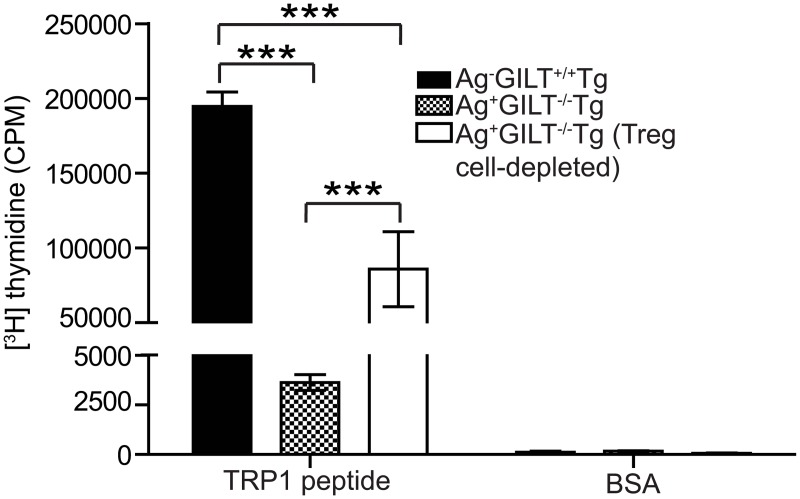
Treg cell depletion partially restores the ability of melanoma-specific T cells from TRP1-expressing mice to proliferate in response to antigen.Total CD4+ and CD4+CD25-T cells were FACS-sorted from Ag+GILT-/-Tg mice and cocultured with irradiated T cell-depleted splenocytes from wild-type mice and TRP1 peptide for five days. Total CD4+ T cells from Ag-GILT+/+Tg mice were included as a positive control. Columns and bars represent means ± standard error of pooled data from two independent experiments compared by ANOVA with the Tukey correction for multiple comparisons (***p<0.001).